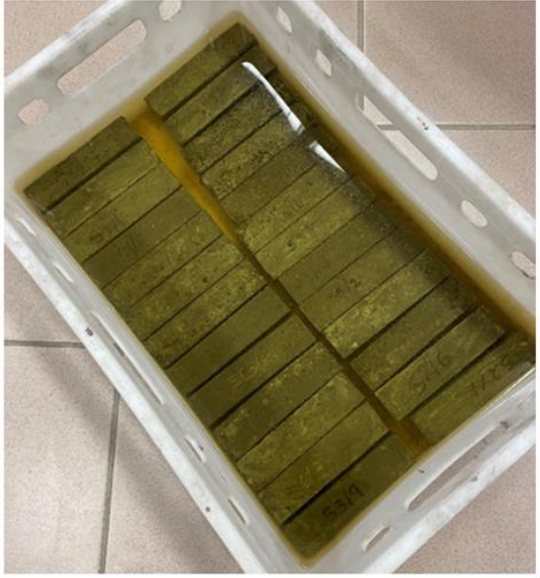
Figure 2. Samples 40 mm × 40 mm × 160 mm during